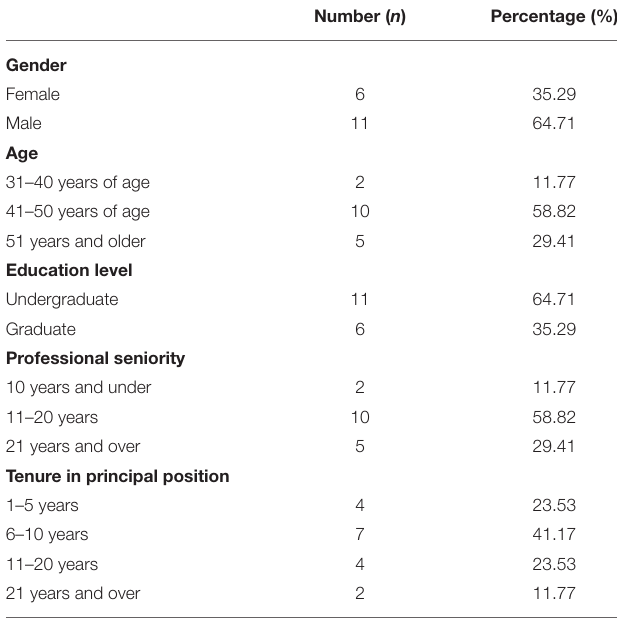
TABLE 1 | Distribution of teacher numbers by regions. Region